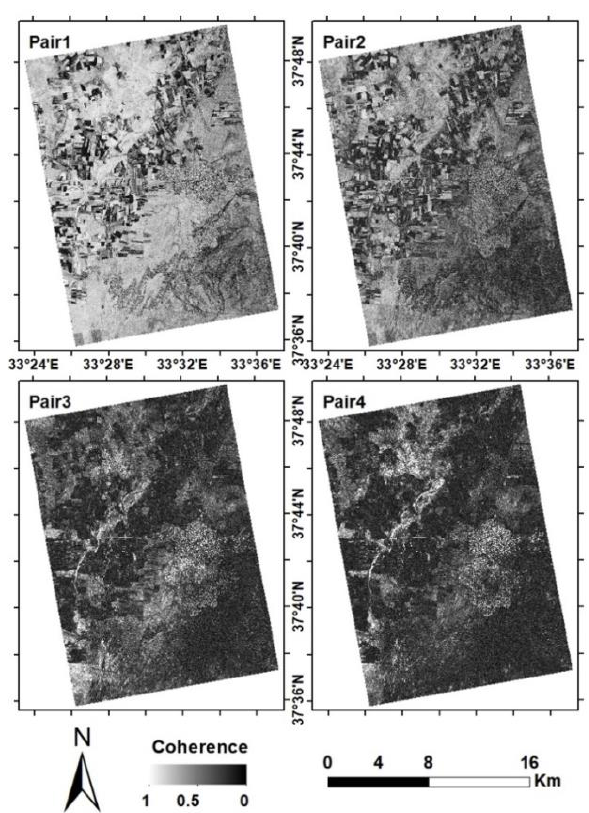
Figure 3. Coherence maps of the pairs (PAZ satellite image © Hisdesat Servicios Estratégicos S.A.,